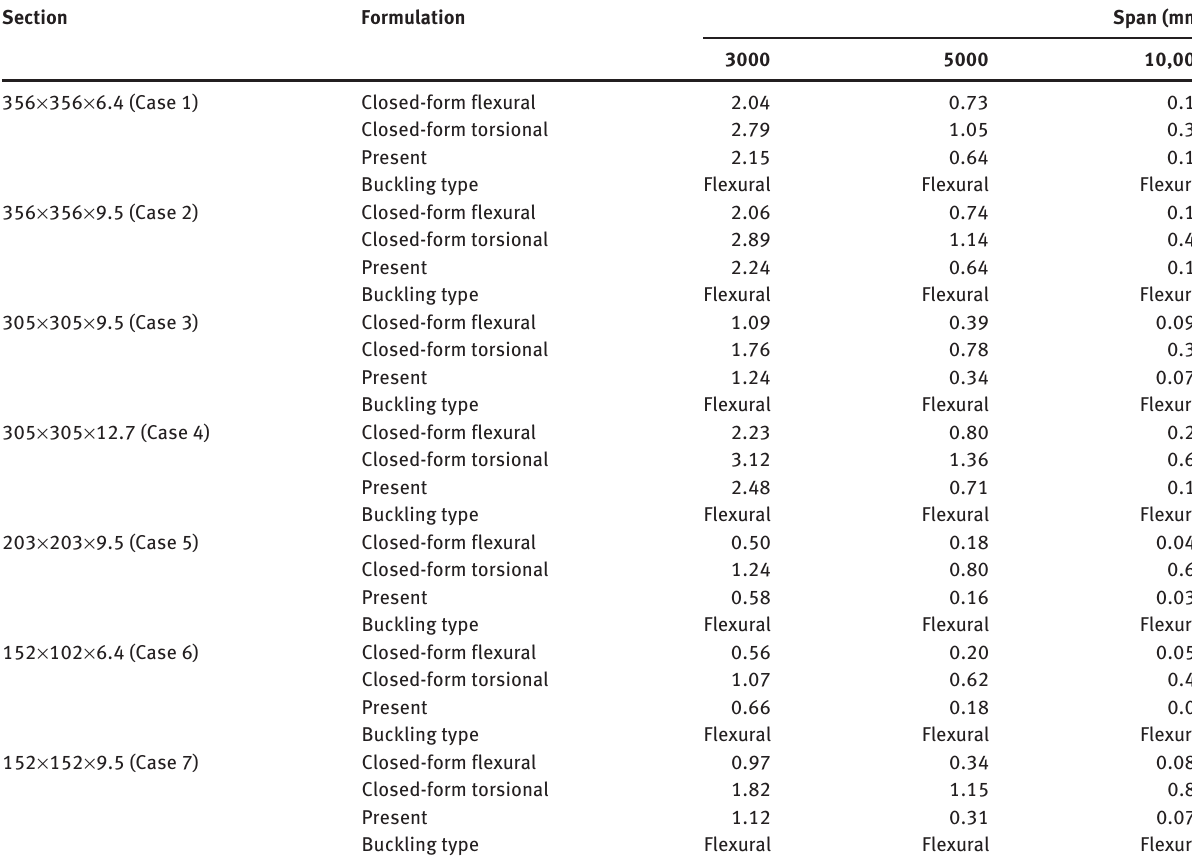
Table 7 Normalized critical buckling stresses of FRP I-shaped section